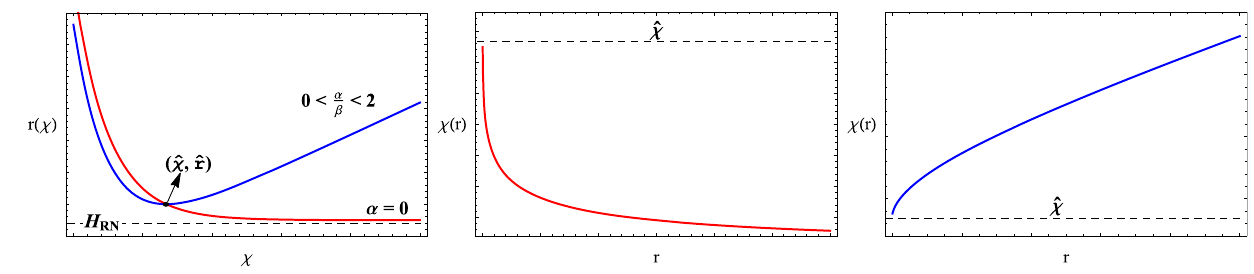
Fig. 1 Left panel: The throat located at the point ( ˆ χ, ˆ r ) (blue curve) and the GR limit (red curve), against χ . Middle panel: The χ variable as a function of the radial r one, for points χ < ˆ χ . Right panel: The χ variable versus the radial r one for points χ > ˆ